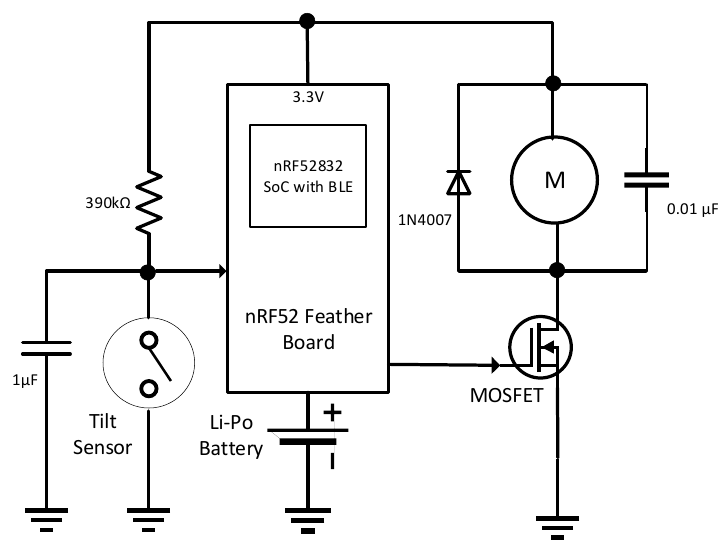
Figure 6. Block diagram of the wearable gadget hardware.